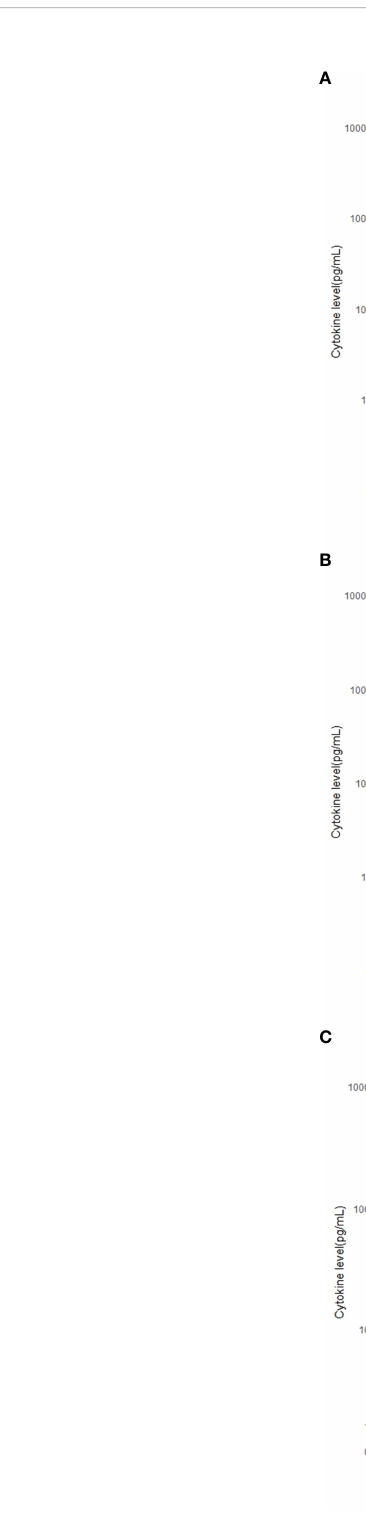
FIGURE 1 Induced cytokine concentration according to nadir CD4+ T-cell count before cART initiation. (A) Stimuli: LPS, (B) Stimuli: R848, (C) Stimuli: PolyI:C. Grey areas indicates 5-95% reference interval. * and ** indicates p-values ≤ 0.05 and ≤ 0.01,